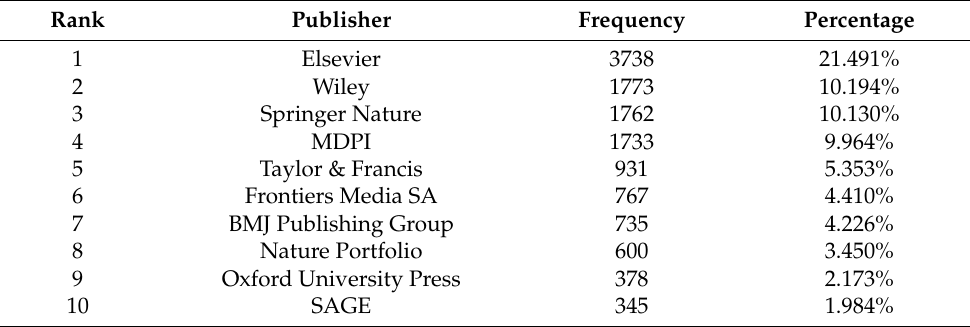
Table 5. The top 10 publishers of journals with papers on COVID-19